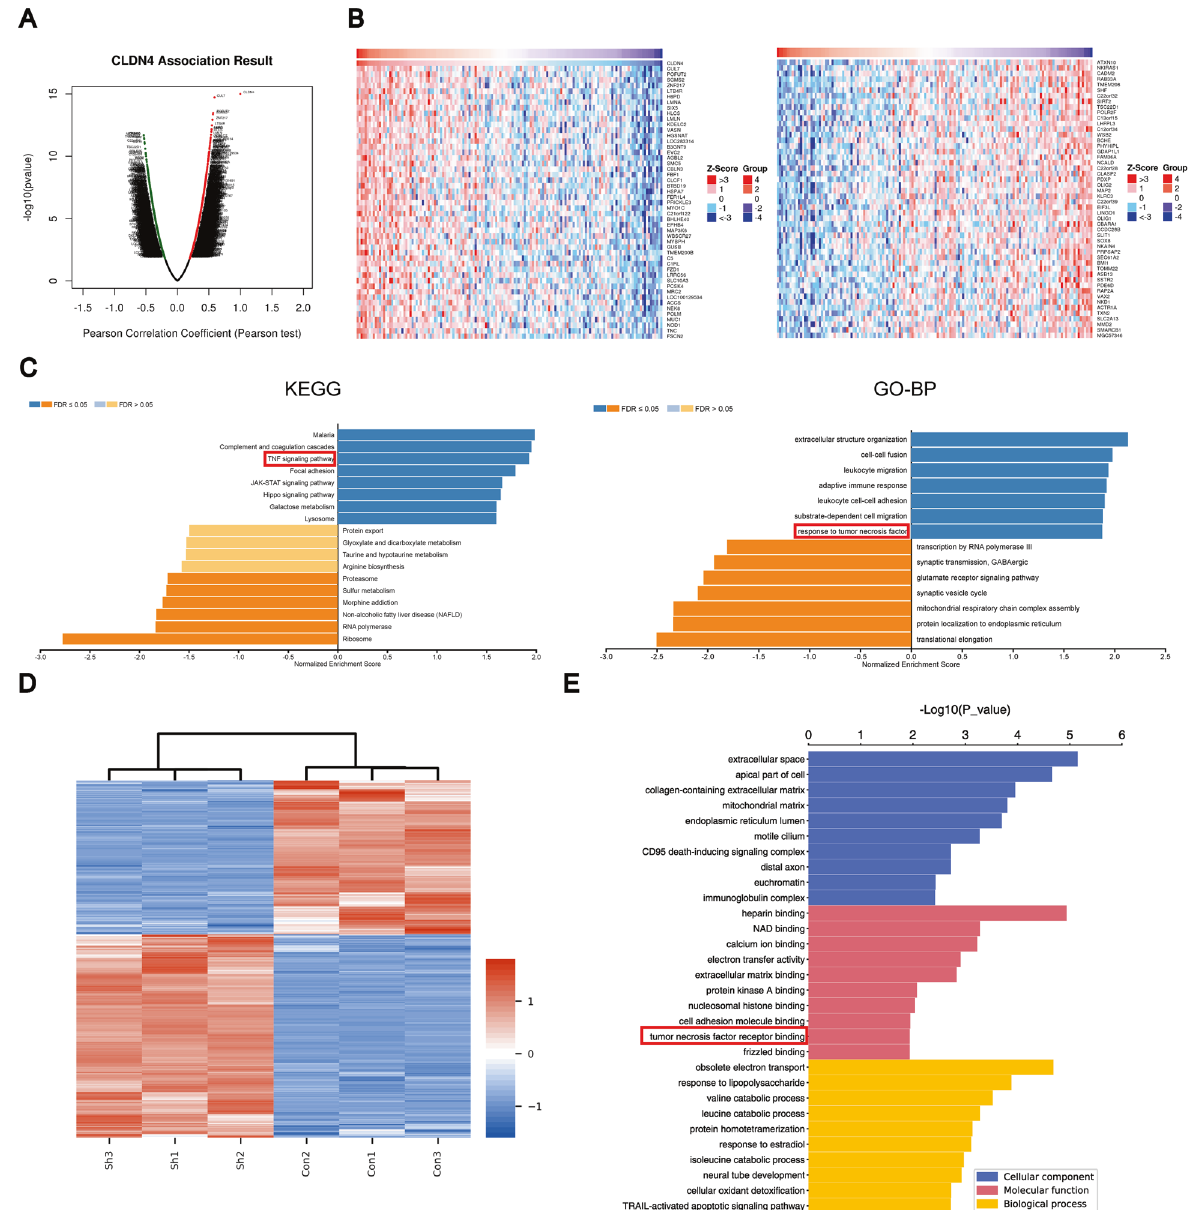
Fig. 3 CLDN4 gene enrichment analysis. A Volcano plot showing DEGs based on Pearson correlation coef fi cient in the TCGA data set. B Heat map showing relative expression levels ( z -score) of top 50 most signi fi cant DEGs. C GO-BP and KEGG pathway analysis of indicated DEGs (FDR < 0.05 and FDR > 0.05). D Clustering of DEGs were identi fi ed by proteomics. E GO analysis performed downregulated genes in